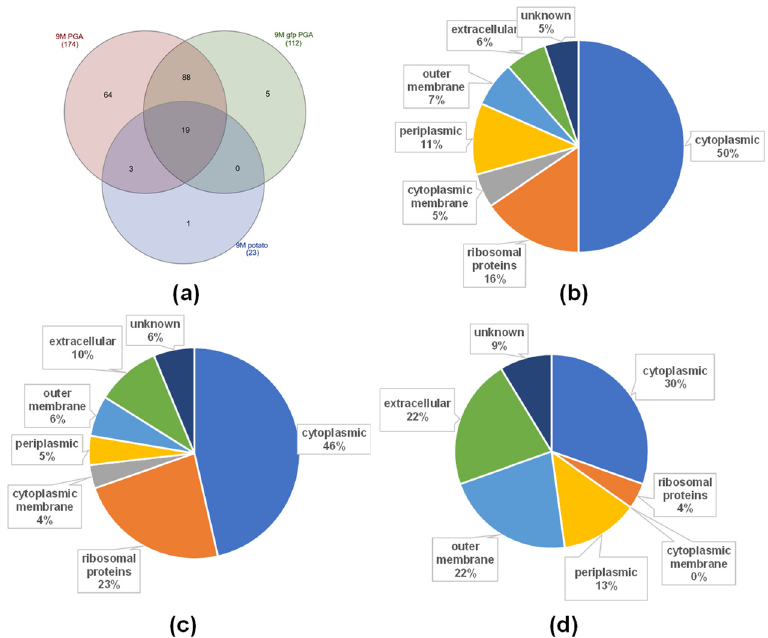
Figure 6. Proteomic analysis of the MVs derived from P. zantedeschiae 9M and the GFP-tagged strain cultured in the M63 medium supplemented with 0.2% glycerol and 0.4% PGA, and P. zantedeschiae 9M cultured in the M63 medium supplemented with 0.2% glycerol and 10% potato extract. ( a ) Venn diagram of proteins overlapping and exclusive for the three MVs samples. Pie charts depict the percentage of proteins in each localization for the MVs of ( b ) P. zantedeschiae 9M, ( c ) the GFP-tagged strains cultured in the M63 medium supplemented with 0.2% glycerol and 0.4% PGA, ( d ) P. zantedeschiae 9M cultured in the M63 medium supplemented with 0.2% glycerol and 10% potato extract.